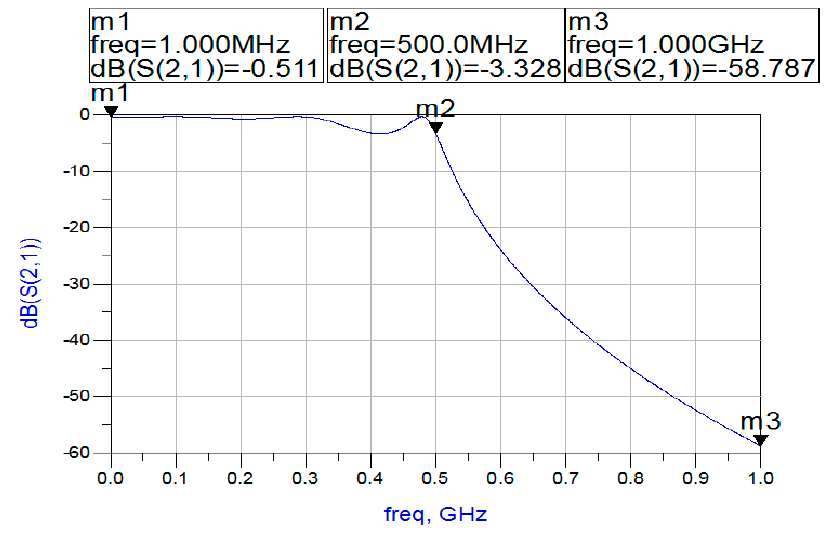
Figure 7. Simulation of low-pass filter in ADS 2011.